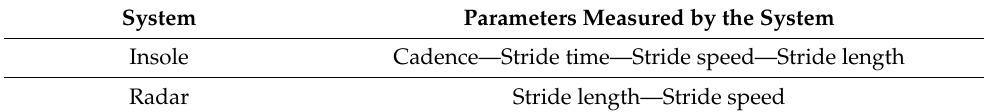
Table 1. Gait parameters computed by the instrumented insole and the radar during the TUG test.